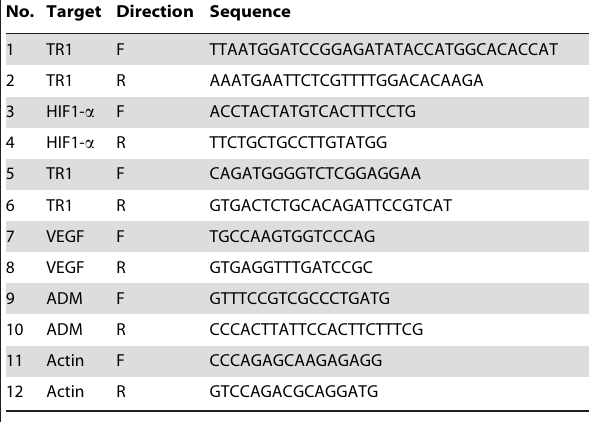
Table 1. Oligonucleotide probes used in this